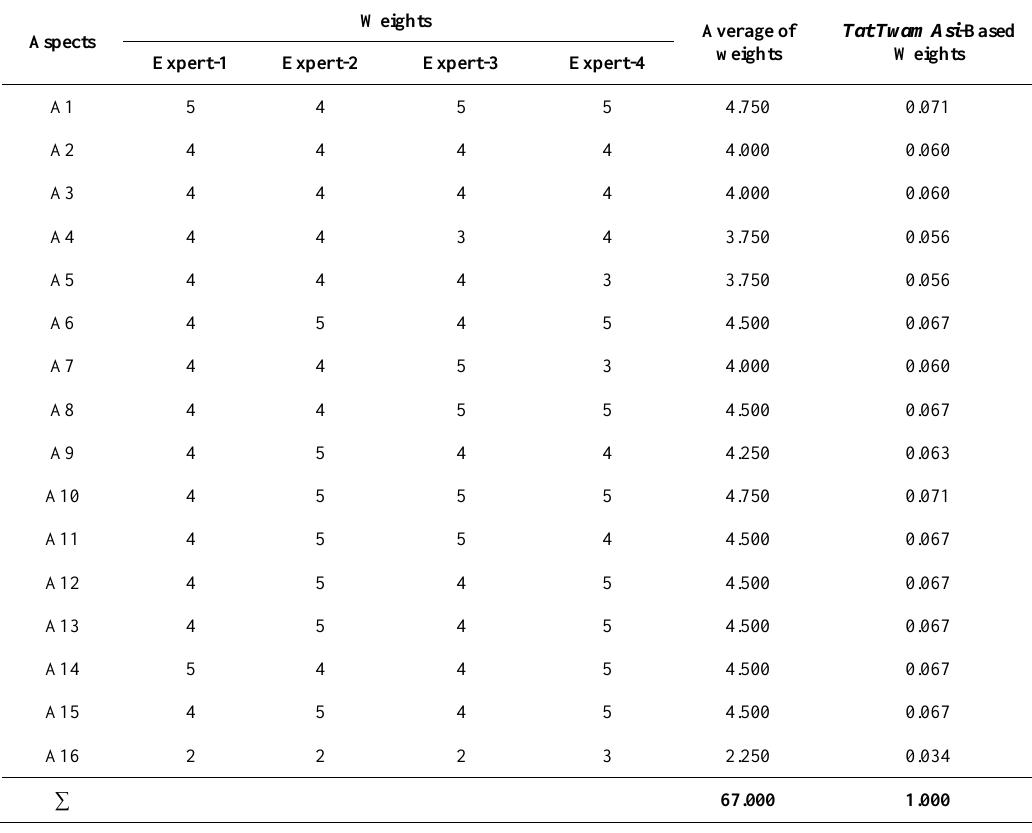
Table 4. The weights of the experts/decision-makers that refers to the Tat Twam Asi